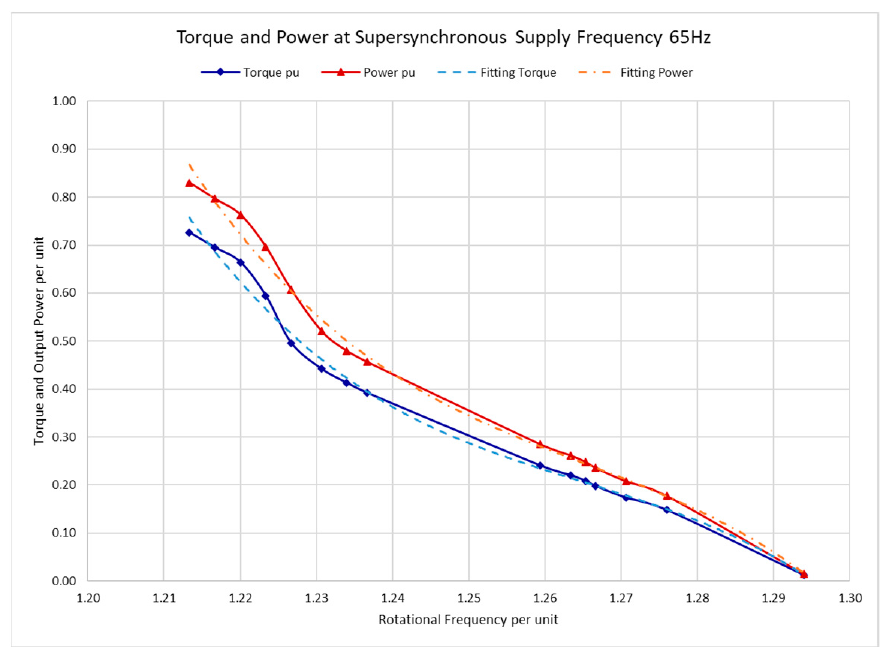
Figure 13. Torque and mechanical power vs. rotational frequency at input frequency 65 Hz (1.3 per unit).